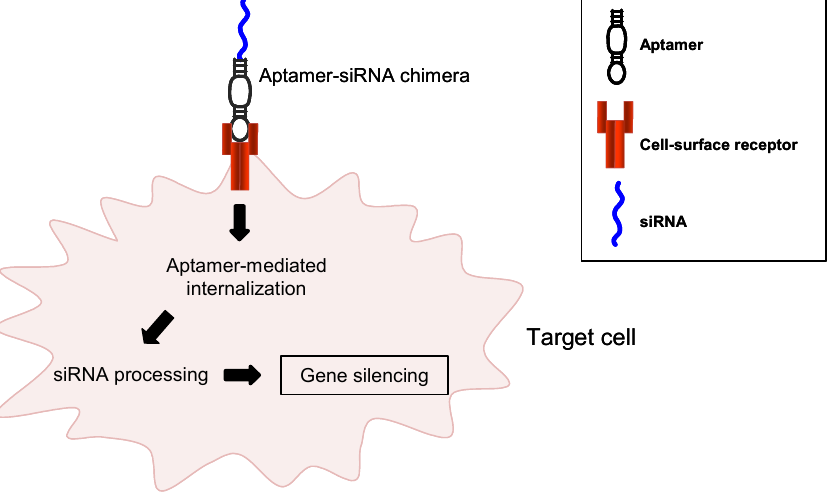
Figure 1. Aptamers as delivery agents. Aptamers that bind to cell surface receptors can be used to deliver siRNA to target